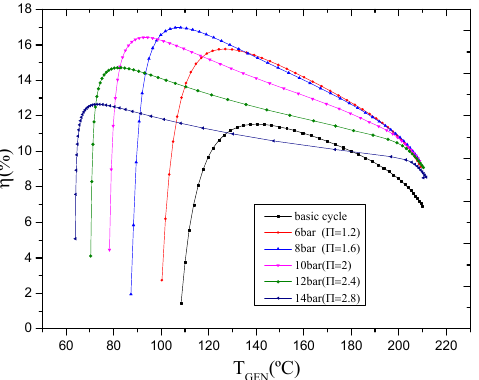
ff erent intermediate pressures. Processes 2019 , 7 , x FOR PEER REVIEW